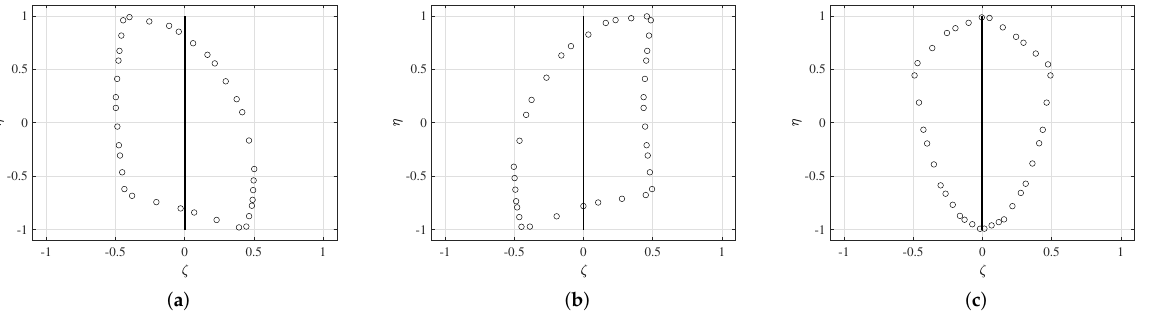
Figure 4. Integration approximations of the three subtendons by the Gauss–Green cubature formula. ( a ) Soleus. ( b ) Medial gastrocnemius. ( c ) Lateral